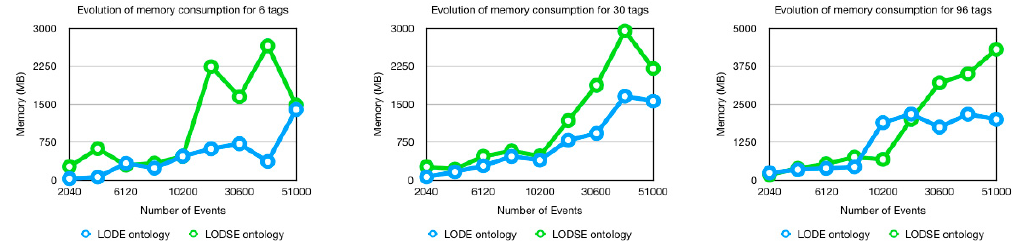
Figure 4. Evolution of memory consumption for 6, 30 and 96 Figure 3. Evolution of memory consumption for 6, 30 and 96 tags. Figure 3. Evolution of memory consumption for 6, 30 and 96 tags.